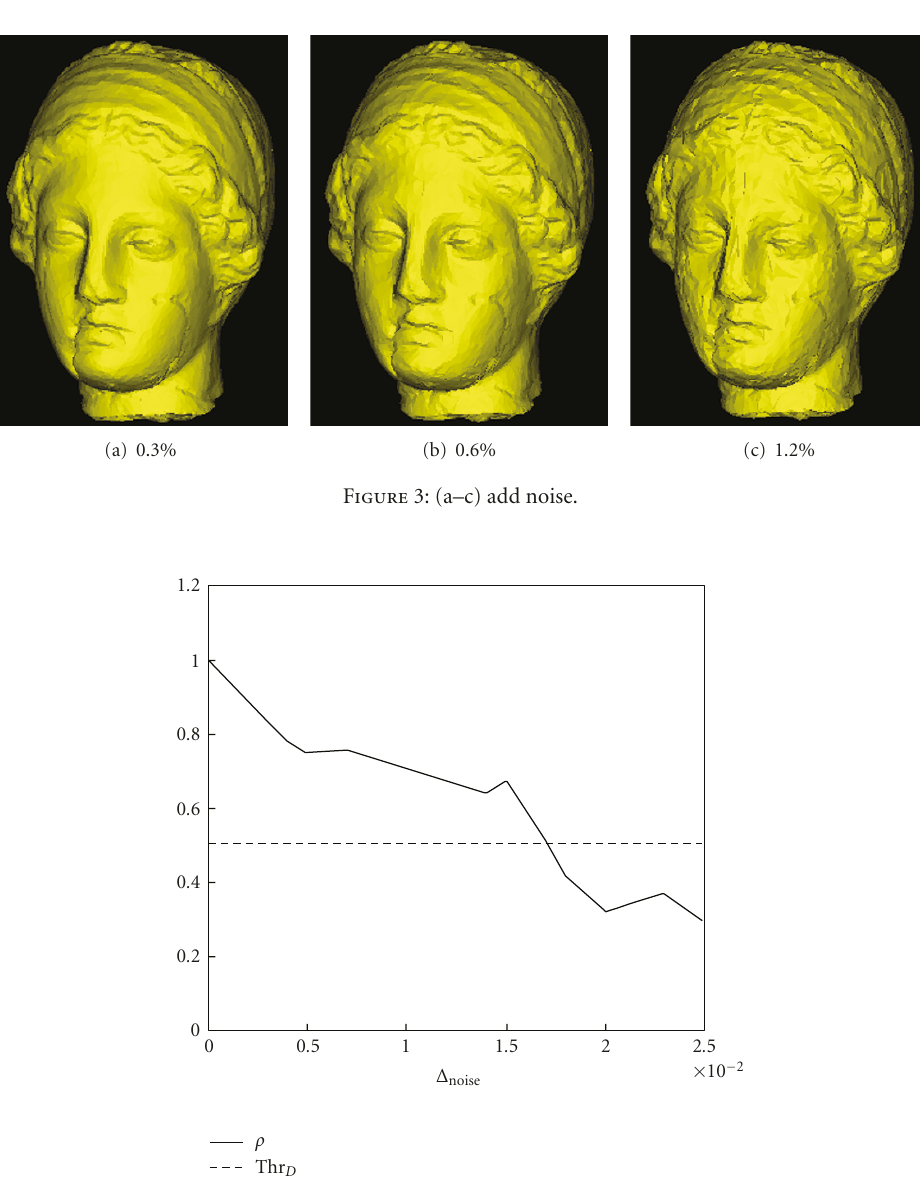
Figure 4: Robustness against additive noise